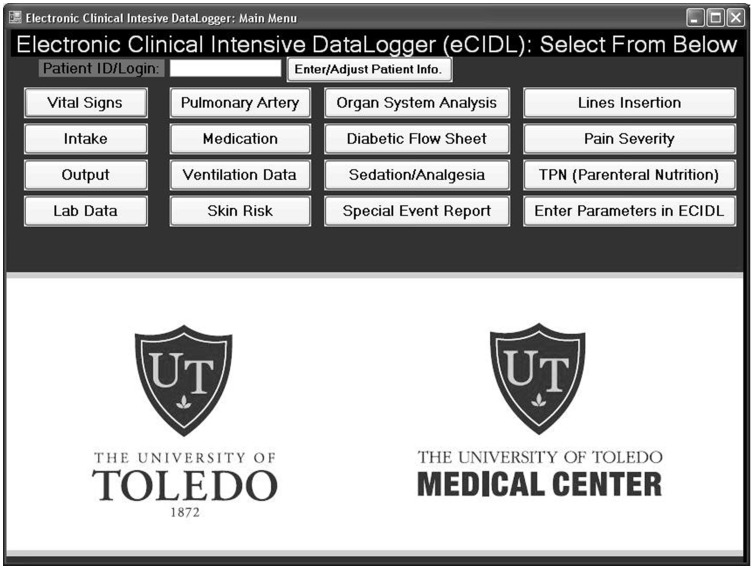
The main menu of the developed Electronic Clinical Intensive Data-Logger (eCIDL).This main menu contains buttons that link the user to various interfaces which contain text fields and drop-down menus to log all medical records present in the comprehensive intensive care unit medical record. This software application was utilized to convert paper-based medical records into electronic records suitable for direct neural network model utilization.